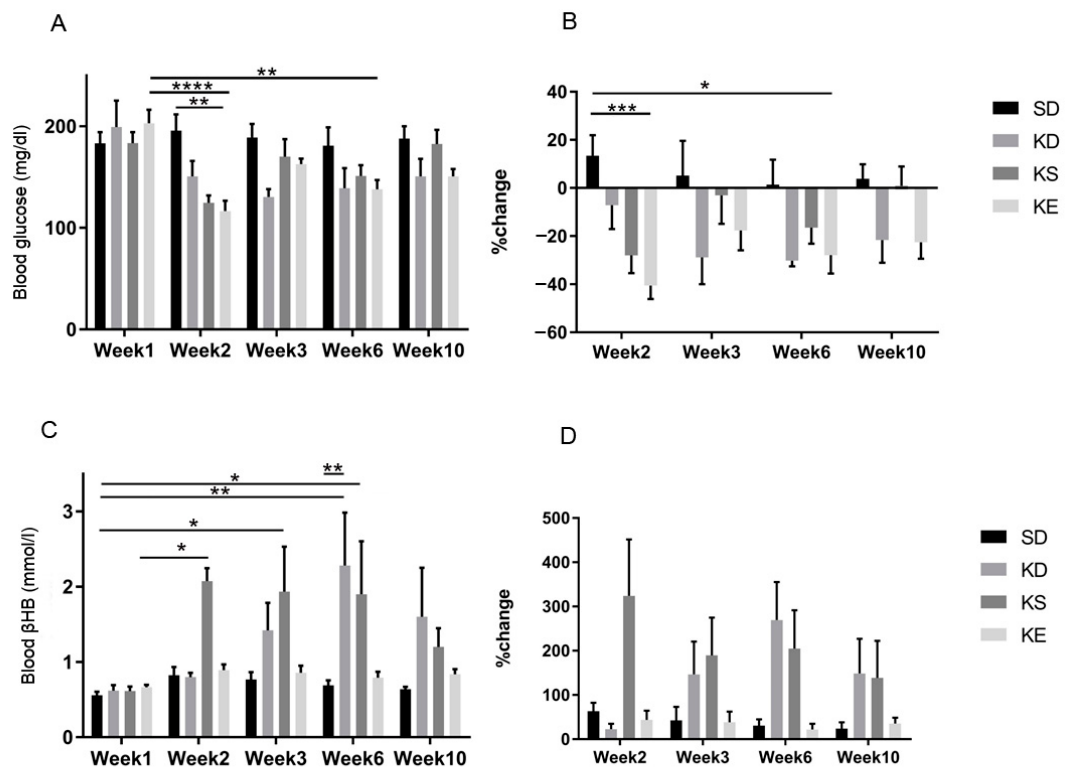
Figure 7. The effect of chronic feeding of ketogenic compounds on blood glucose and R - β HB level was assessed in glucose transporter type 1 (G1D)-deficiency syndrome mice during 10 weeks long experiment, in rested state. ( A ) The change in blood glucose levels in GLUT1D mice, without exercise, chronically exposed to various ketone supplements. ( B ) The corresponding percent change in blood glucose levels. ( C ) The resulting blood R - β HB levels. ( D ) The percent change in blood R - β HB levels. Abbreviations: SD: standard diet (Control); KD: ketogenic diet; KS: ketone salt; KE: ketone ester. *: p<0.05, **: p<0.01, ***: p<0.001 and ****: p<0.0001 level of significance.